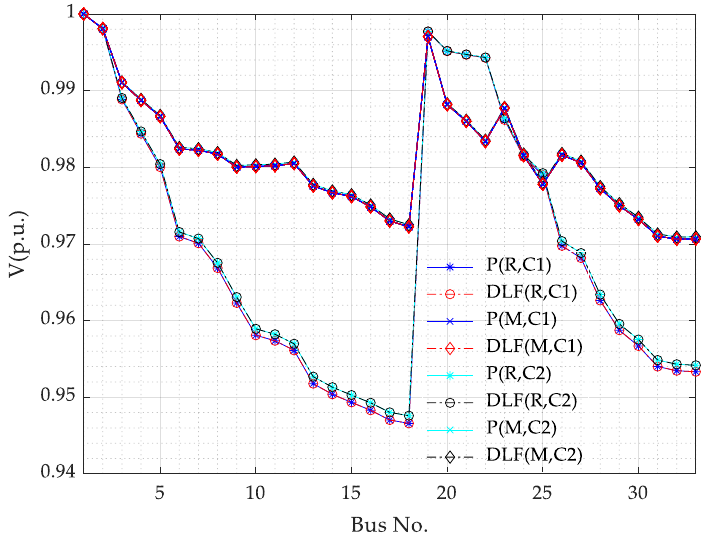
12 of 24 Figure 4. Voltage profile of the 33-node test feeder (Case 1, P = proposed R = radial, M = meshed, DLF = direct load flow). Figure 5 shows the voltage profile of the 33-node test feeder with different load types both for radial and meshed configurations. The results showed that the proposed method was as accurate as DLF but with a faster convergence. The convergence performance is